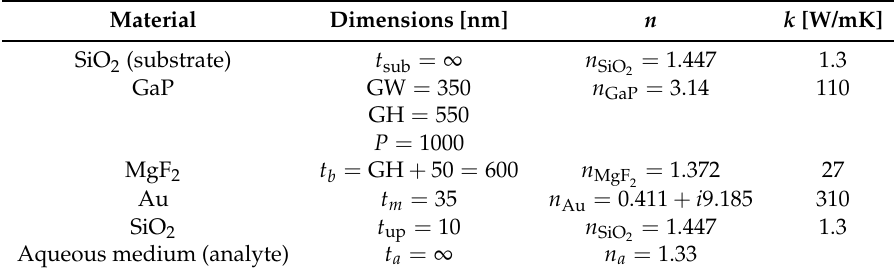
Dimensional and material constants of the device. The optical constants are given at λ 0 = 1.35 µ m.